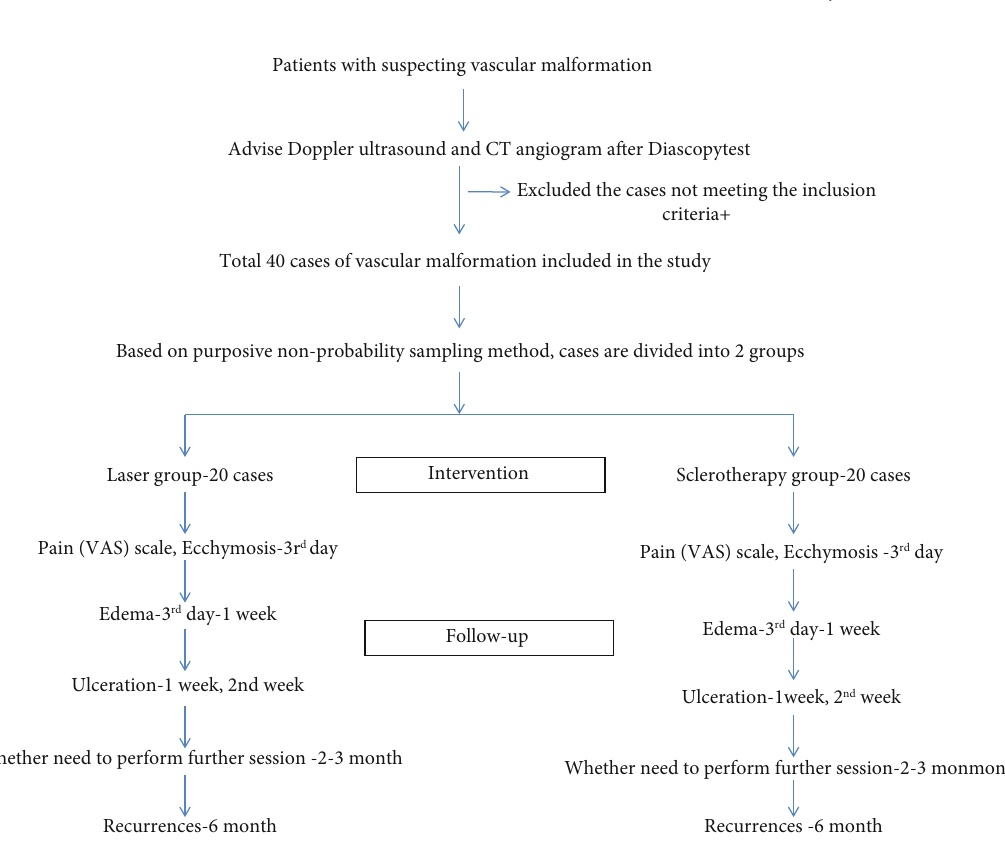
Figure 2: Flow chart to summarize the research